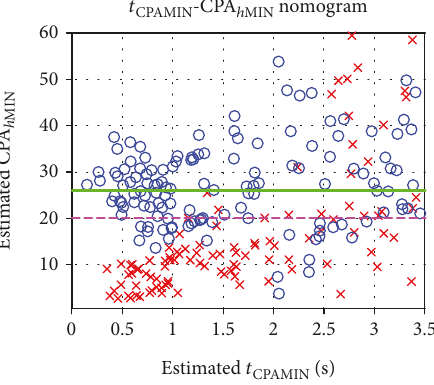
Table 3: Camera system detectability results.